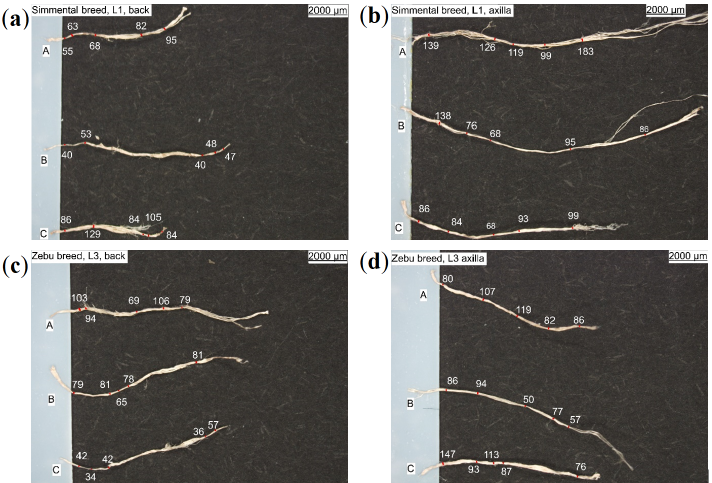
Figure 3. Light microscopic images including dimensioning of collagen fiber-bundles, extracted from ( a , c ) back and ( b , d ) axilla of ( a , b ) Simmental breed, L1 and ( c , d ) zebu,